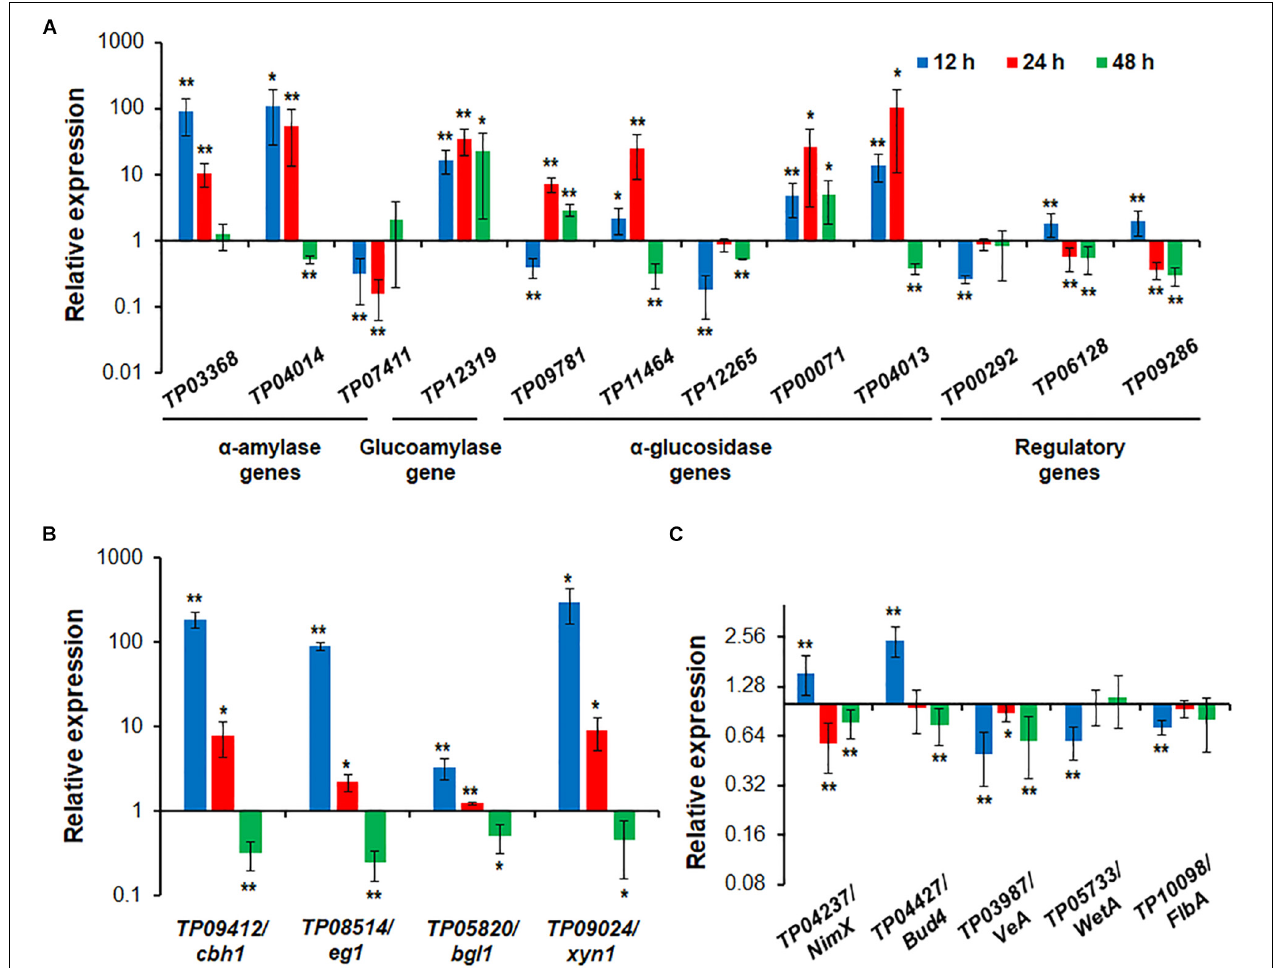
FIGURE 7 | Expressional regulation of enzyme genes and regulatory genes by TP05746 in T. pinophilus as demonstrated by RT-qPCR. (A) Amylase genes and their regulatory genes. Total RNA was extracted from fungal strains cultured in medium containing SCS as the carbon source for 12, 24, and 48 h after transfer from glucose. (B) Cellulase and xylanase genes. (C) Genes involved in conidiogenesis. Fungal cells were cultured on WA for 12, 24, and 48 h after transfer from glucose. Expression levels of the genes tested in the (cid:49) TP05746 mutant were normalized against the parental strain (cid:49) TpKu70 . ∗∗ p ≤ 0.01 and ∗ p ≤ 0.05 indicate differences between (cid:49) TP05746 and (cid:49) TpKu70 by Student’s t test. Each experiment contained three biological replicates. RT-qPCR, real-time quantitative reverse transcription PCR; WA, wheat bran plus